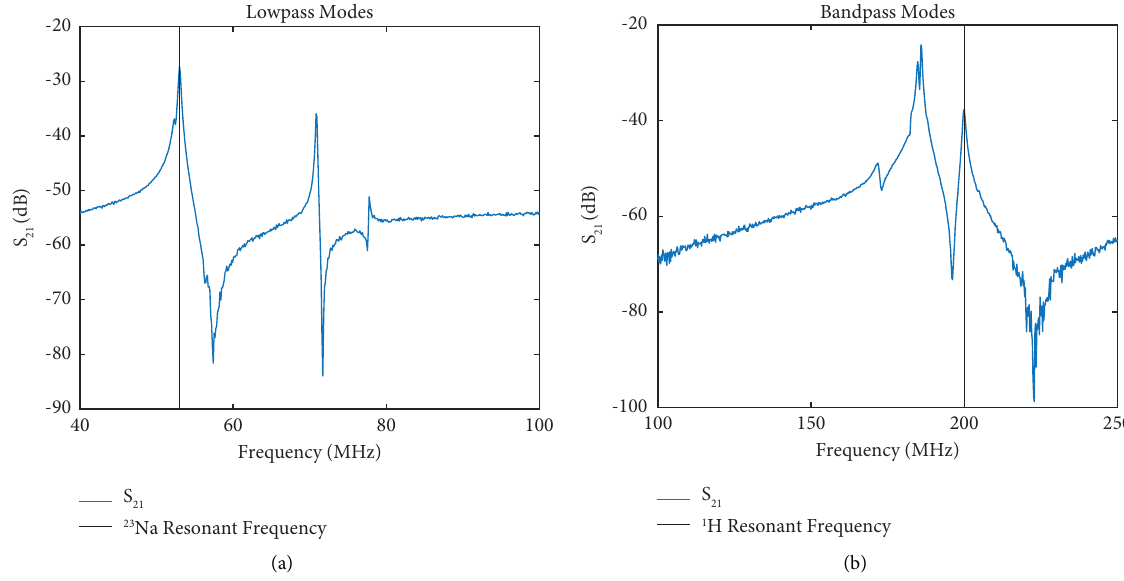
Figure 4: Modes detected by a crossed probe centered in the coil: (a) Resonant modes of a single-tuned nine-leg lowpass birdcage designed for 23 Na at 4.7T. (b) Resonant modes of a single-tuned nine-leg bandpass birdcage designed for 1 H at